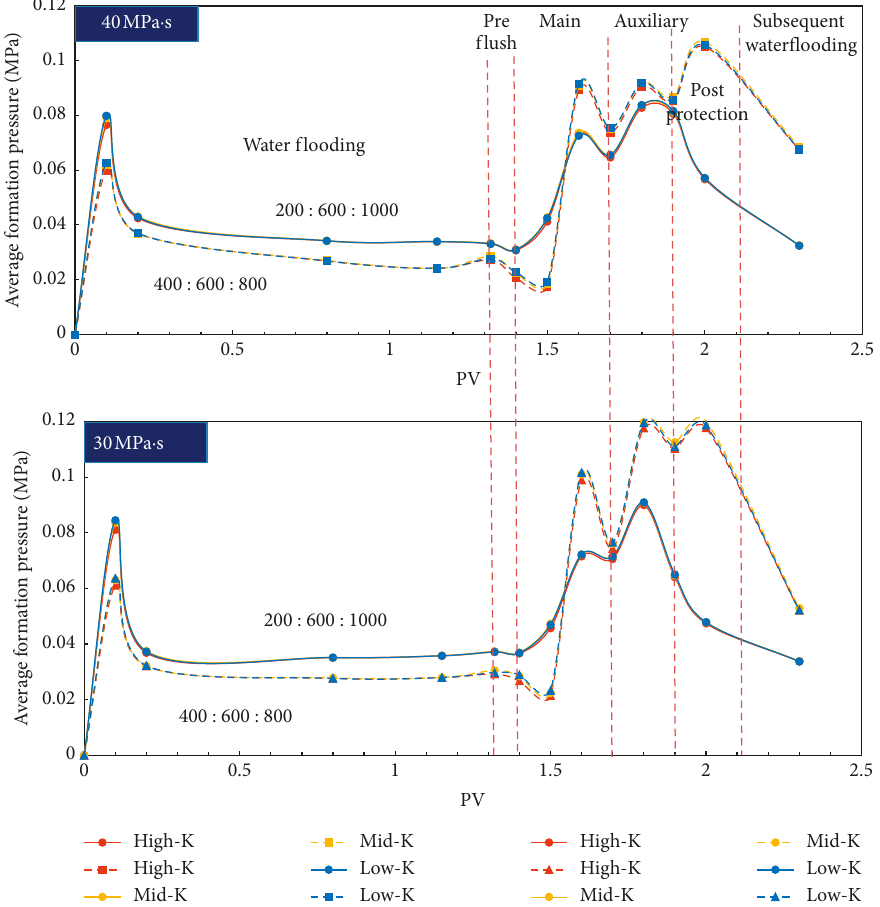
Figure 16: Average pressure curve comparison of different heterogeneities and